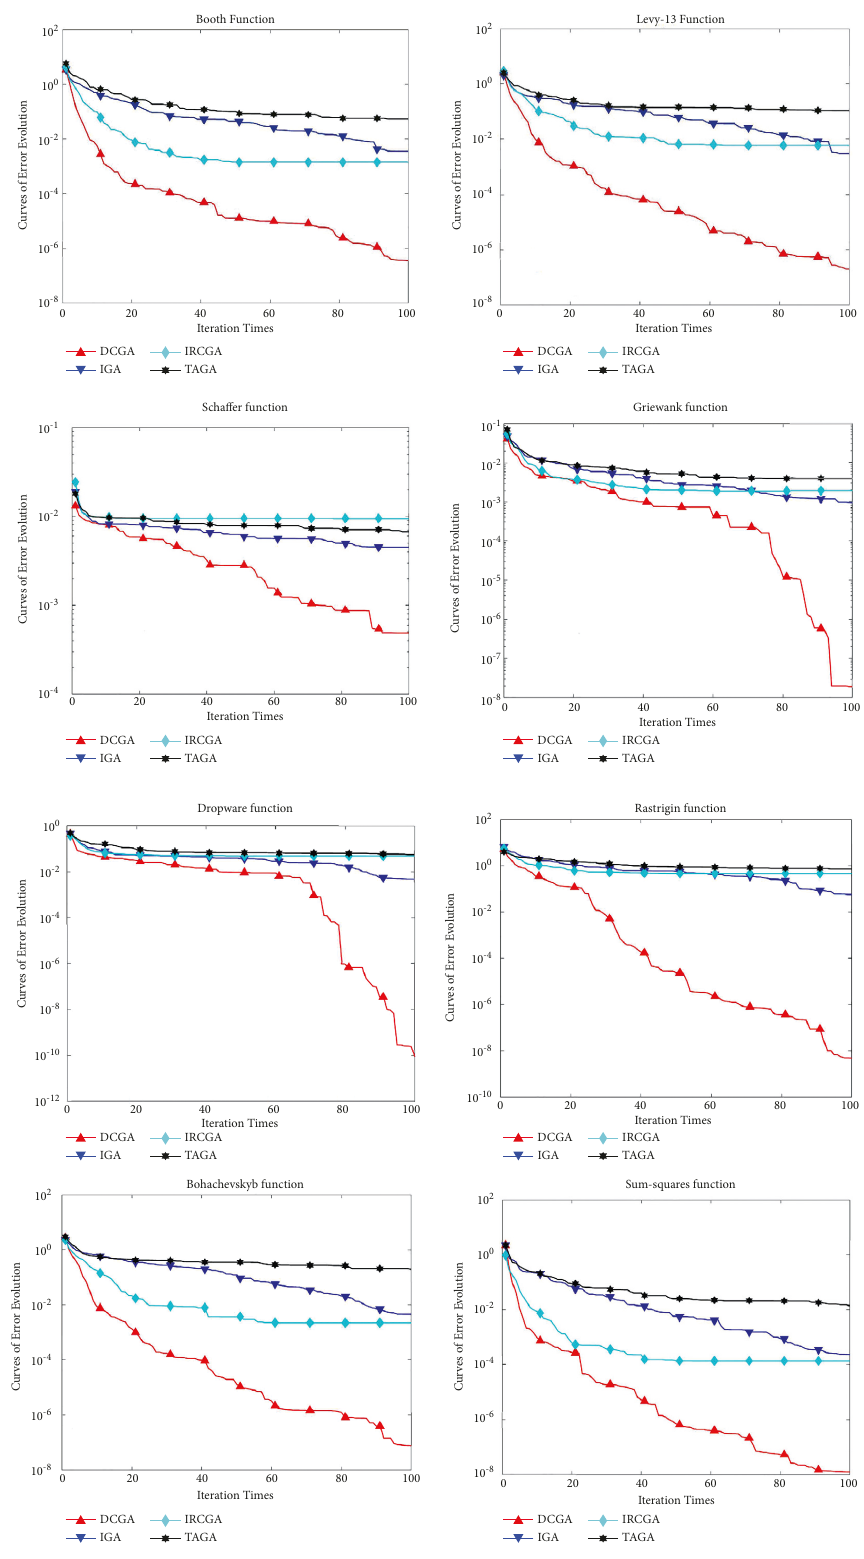
Figure 3: Curves of error